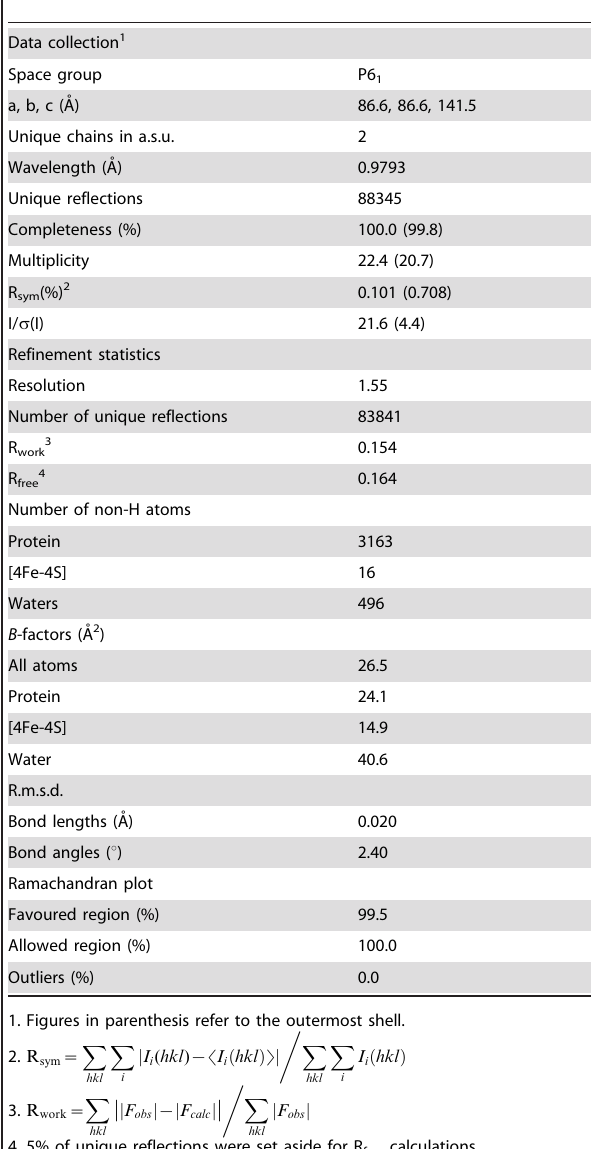
Table 1. X-ray data collection and refinement